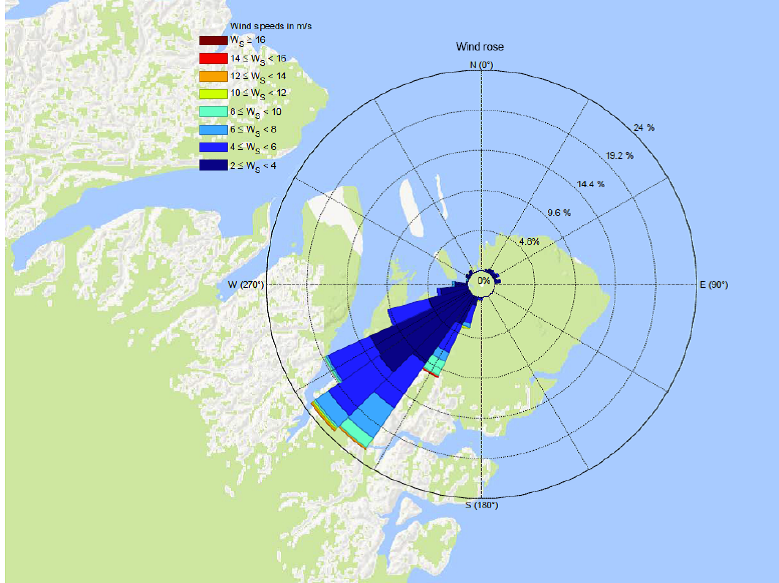
Figure 2. Wind rose centered at Villum Research Station, Station Nord. Length of the bars indicates frequency of the direction and color indicates the wind speed. Units are in ms − 1